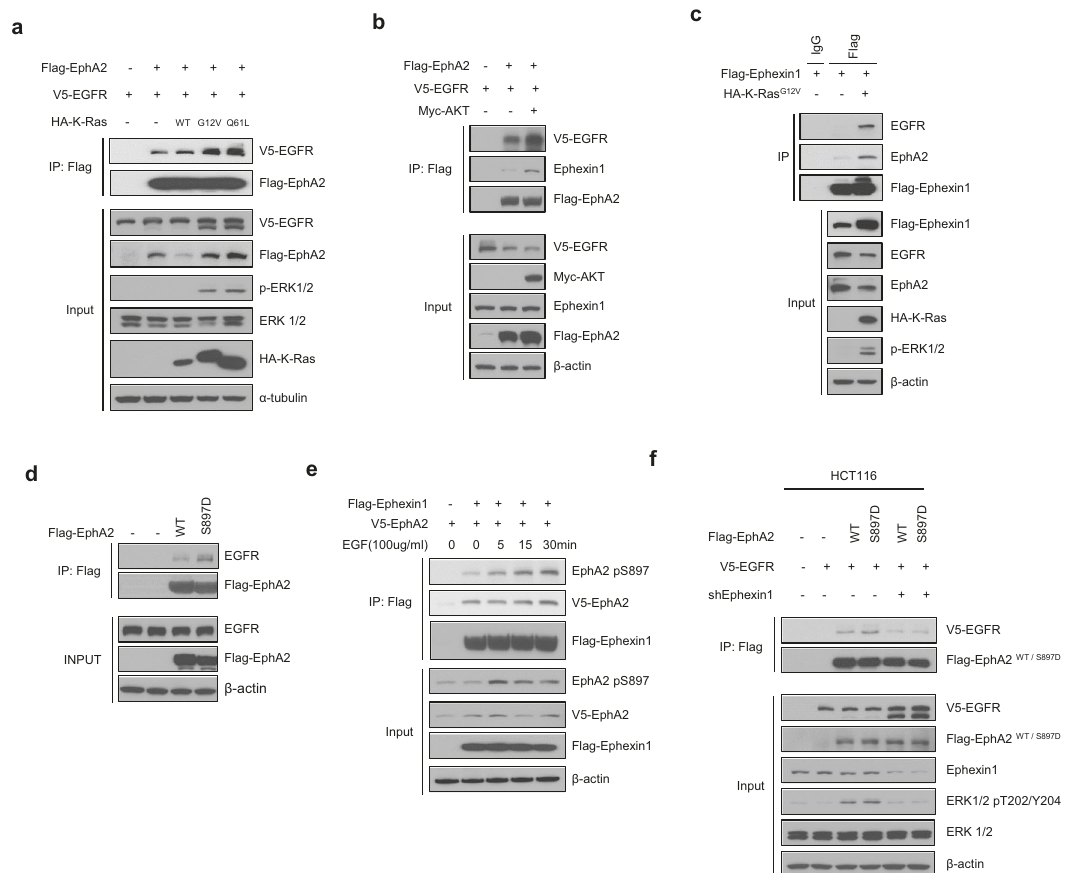
Fig. 4 AKT mediates phosphorylation of EphA2 at Ser897 which then promotes binding to EGFR in the presence of Ephexin1. For each experiment, immunoprecipitation was carried out with protein extracts from the indicated HEK293T cell lines using anti-Flag antibody and then the precipitate was analyzed by western blot analysis using antibodies indicated in the panels. a Extracts from cells co-transfected with Flag-EphA2, V5-EGFR and HA-K-Ras (WT, G12V, and Q61L) plasmids. b Extracts from cells transfected with Flag-tagged EphA2, V5-tagged EGFR along with or without Myc-tagged myr-AKT (constitutively active). c Extracts from cells co-transfected with Flag-tagged Ephexin1 with or without HA-tagged K-Ras G12V plasmids. d Extracts from cells transfected with Flag-tagged EphA2 WT or S897D plasmids. e Extracts from cells co-transfected with Flag-tagged Ephexin1 and V5-tagged EphA2 that were treated with EGF (100 ng/ml) after 16 h serum starvation. Western blot analysis was carried out using anti-EphA2 pSer897 antibody. f Extracts from cells co-transfected with Flag-tagged EphA2 WTor S897D, V5- tagged EGFR with or without shEphexin1